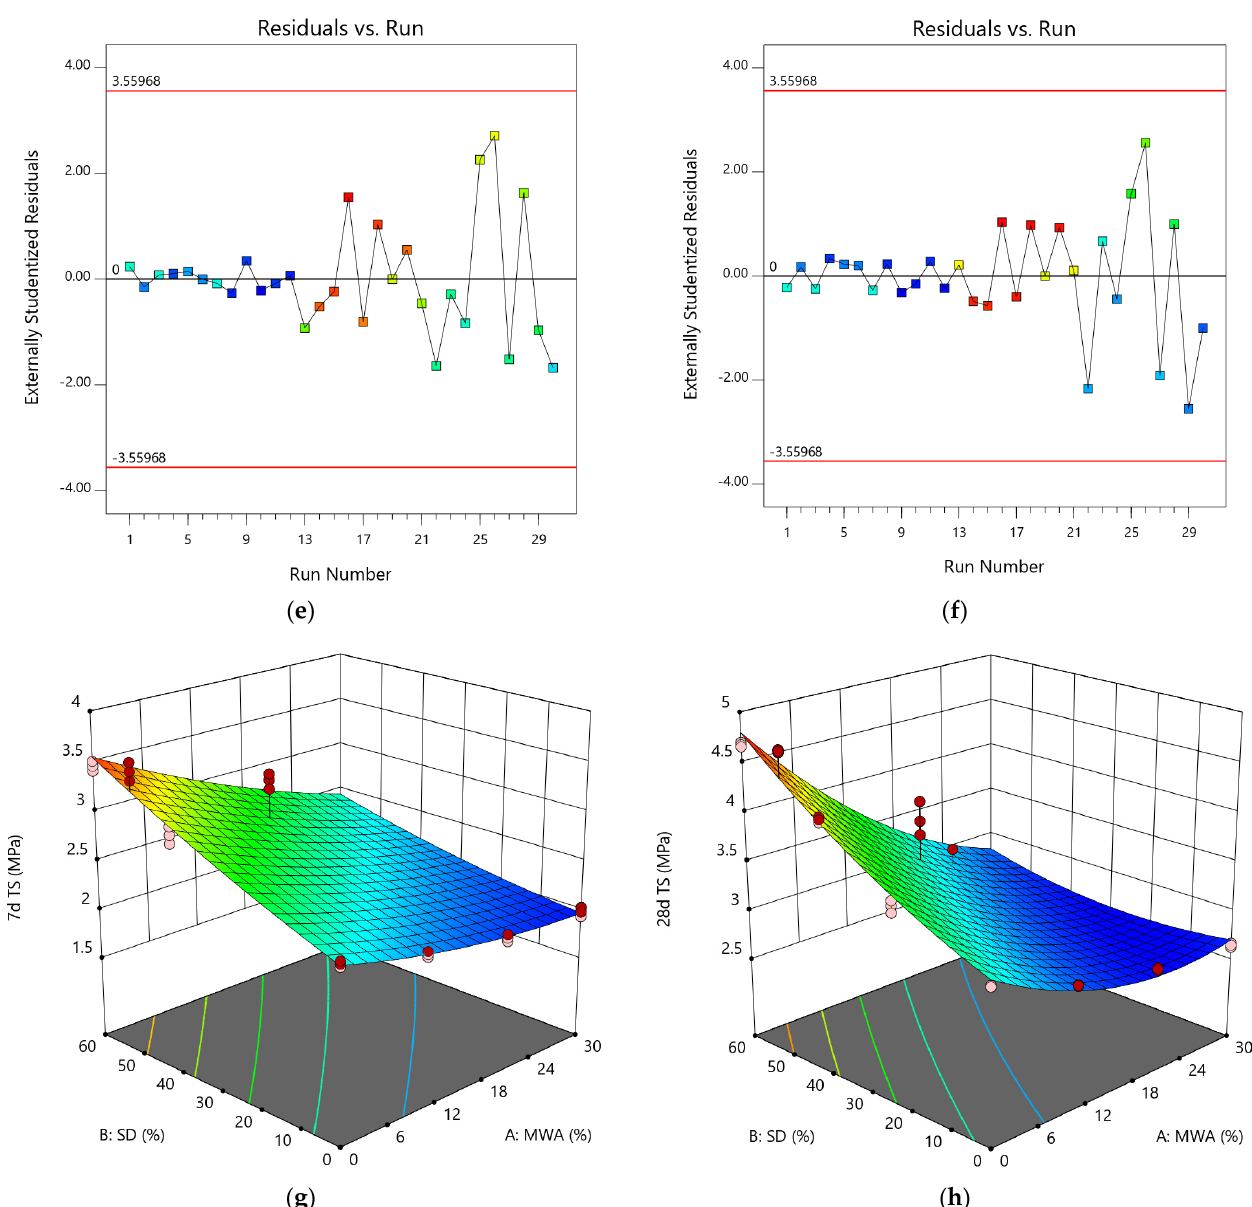
Figure 9. Diagnostic and 3D plots of 7-day and 28-day split tensile strength. ( a ) 7-day split tensile strength, ( b ) 28-day split tensile strength, ( c ) 7-day split tensile strength, ( d ) 28-day split tensile strength, ( e ) 7-day split tensile strength, ( f ) 28-day split tensile strength, ( g ) 7-day split tensile strength, ( h ) 28-day split tensile strength.